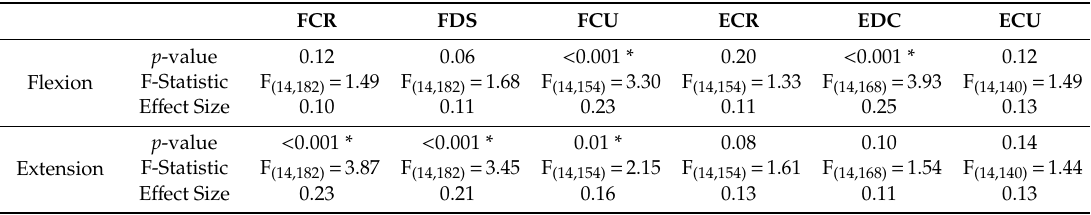
Table 3. Results from one-way (measurement time) repeated measures ANOVAs performed separately for each collection session on raw MEP amplitudes.